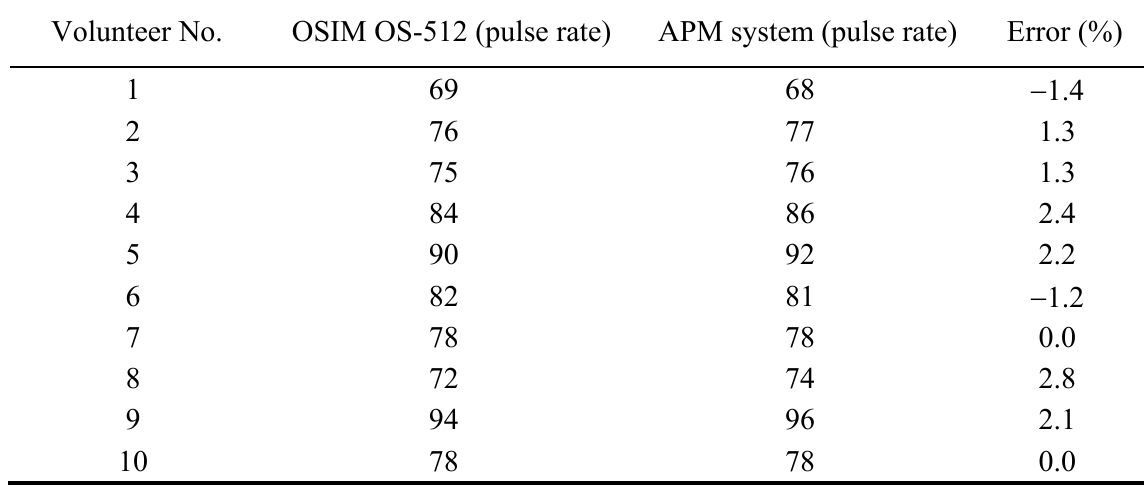
Table 2 . Comparison of the frequency measurements made by the APM system and a blood pressure monitor (Model No.: OS-512, OSIM,